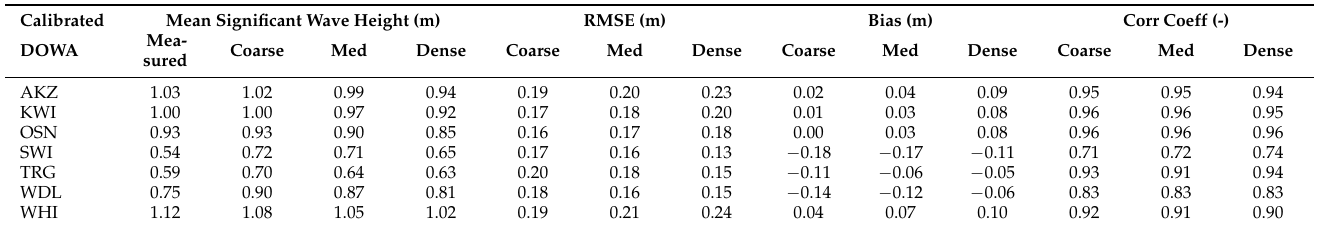
Table 12. Calibrated SWAN model forced by the DOWA wind database showing the mean wave heights, RMSE, Bias and correlation coefficient relative to measured data at Belgian coastal measuring stations.